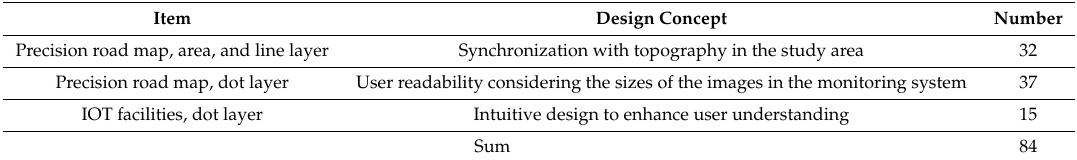
Table 3. Design performance. Abbreviations: IOT, Internet of Things.